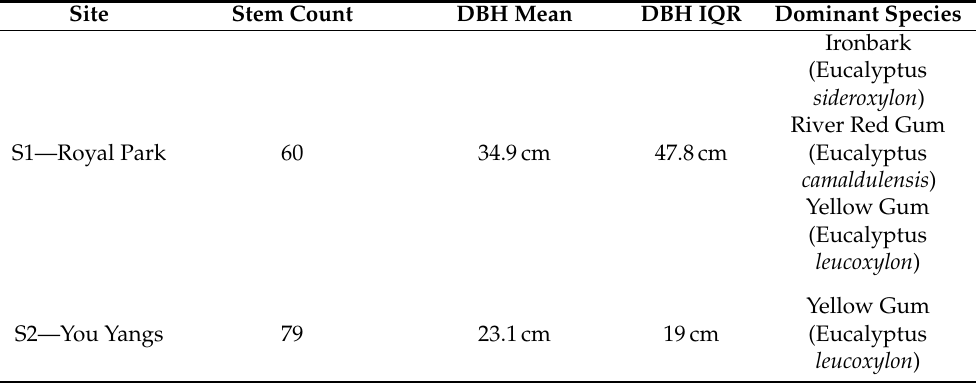
Table 1. Stem counts, Please confirm color on table and please confirm table format. diameter at breast height (DBH) characteristics, and dominant species within site one (S1), at Royal Park (urban parkland), and site two (S2), at the You Yangs National Park (native